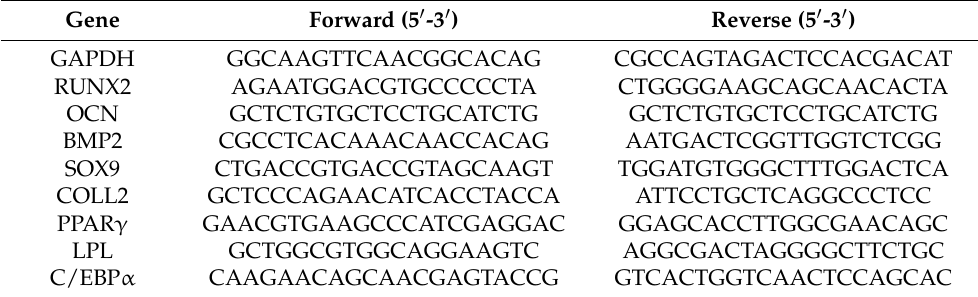
Table 1. Primers used for